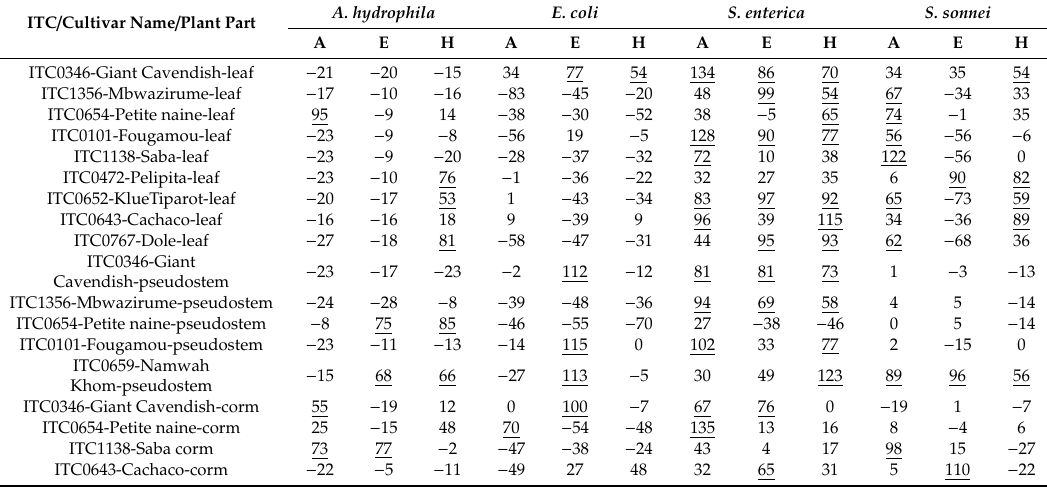
Table 4. Antibacterial activity of selected extracts from banana cultivars against Gram-negatives (relative inhibition in